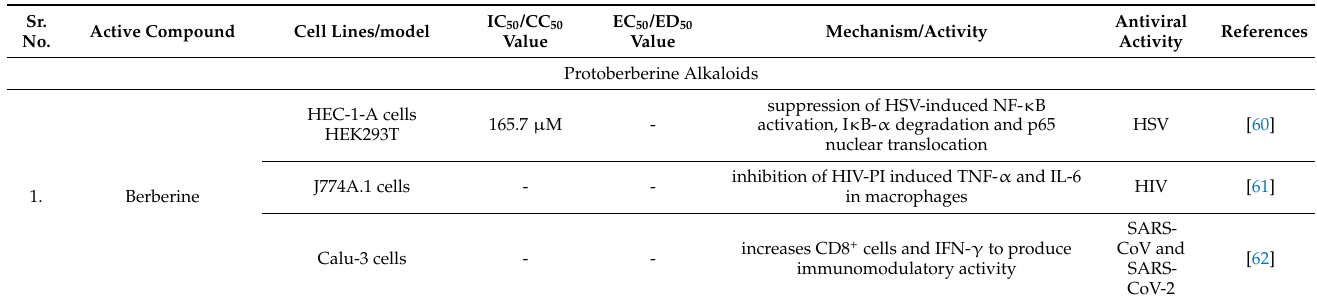
Table 2. In vitro activities of isoquinoline and related alkaloids against several viral infections. Sr.